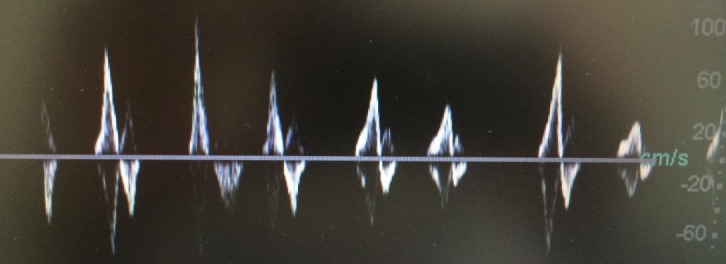
Atrial fibrillation.